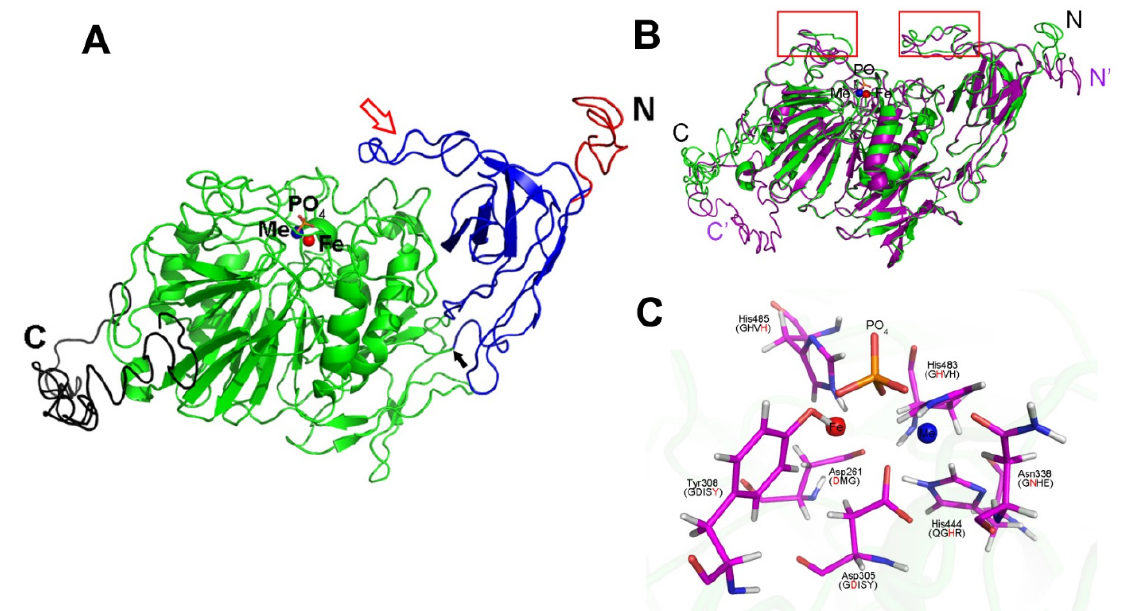
Figure 5. Predicted structure of AtPAP9. ( A ) Different domains of an AtPAP9 monomer unit are shown in different colors (red, transit peptide; blue, FN-III-like domain; green, PAP catalytic domain; black, C-terminal hydrophobic motif; blue sphere, Me (Zn or Mn) atom; red sphere, Fe atom; orange spheres, PO 4 ). The flexible loop is indicated by a red arrow, and the hinge connecting the FN-III-like and PAP catalytic domains is indicated by a black arrow. ( B ) The alignment of AtPAP2 (purple) and AtPAP9 (green) is shown as a cartoon by indicating their N- and C-termini, respectively. The metal atoms and phosphate ligands are displayed as spheres. The main different areas are boxed in red frames. ( C ) Active site and bound phosphate of AtPAP9. The Fe and Me atoms are displayed as red and blue spheres, respectively. The phosphate ligands are shown as sticks (red and yellow). The Fe atom is coordinated by amino residues His485, Tyr308, Asp261, and Asp305. The Me atom is coordinated by His444, His 483, Asn338, and Asp305. All the metal-chelating residues are shown as sticks as well by labeling the five conserved PAPs motifs (DMG, GDISY, GNHE, QGHR, and GHVH).